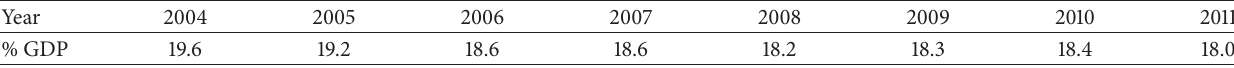
Table 2: Agriculture value added (% of GDP).